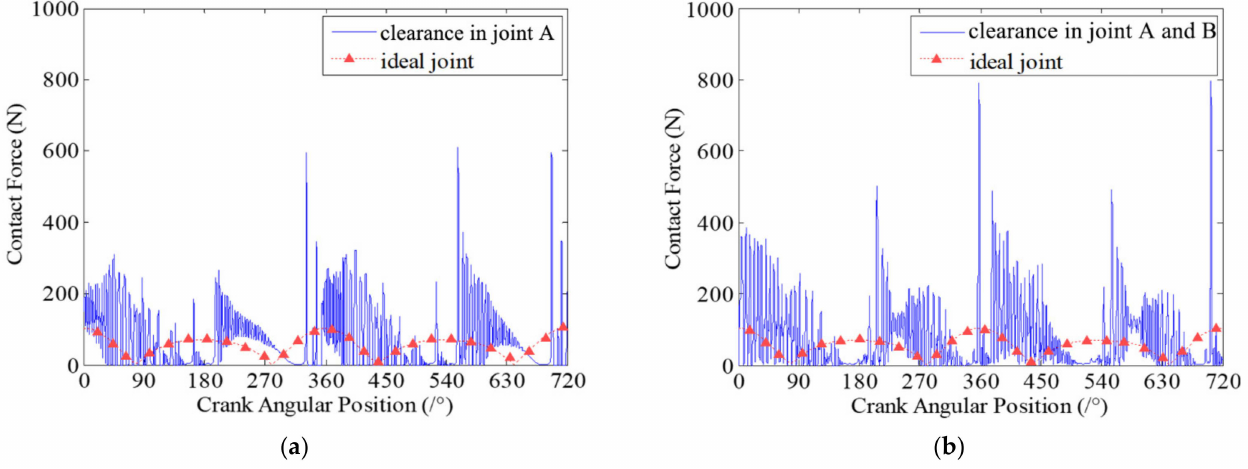
Figure 5. Contact forces in revolute clearance joint A. ( a ) case 1: there is one clearance joint in the mechanism; ( b ) Case 2: there are two clearance joints in the mechanism.